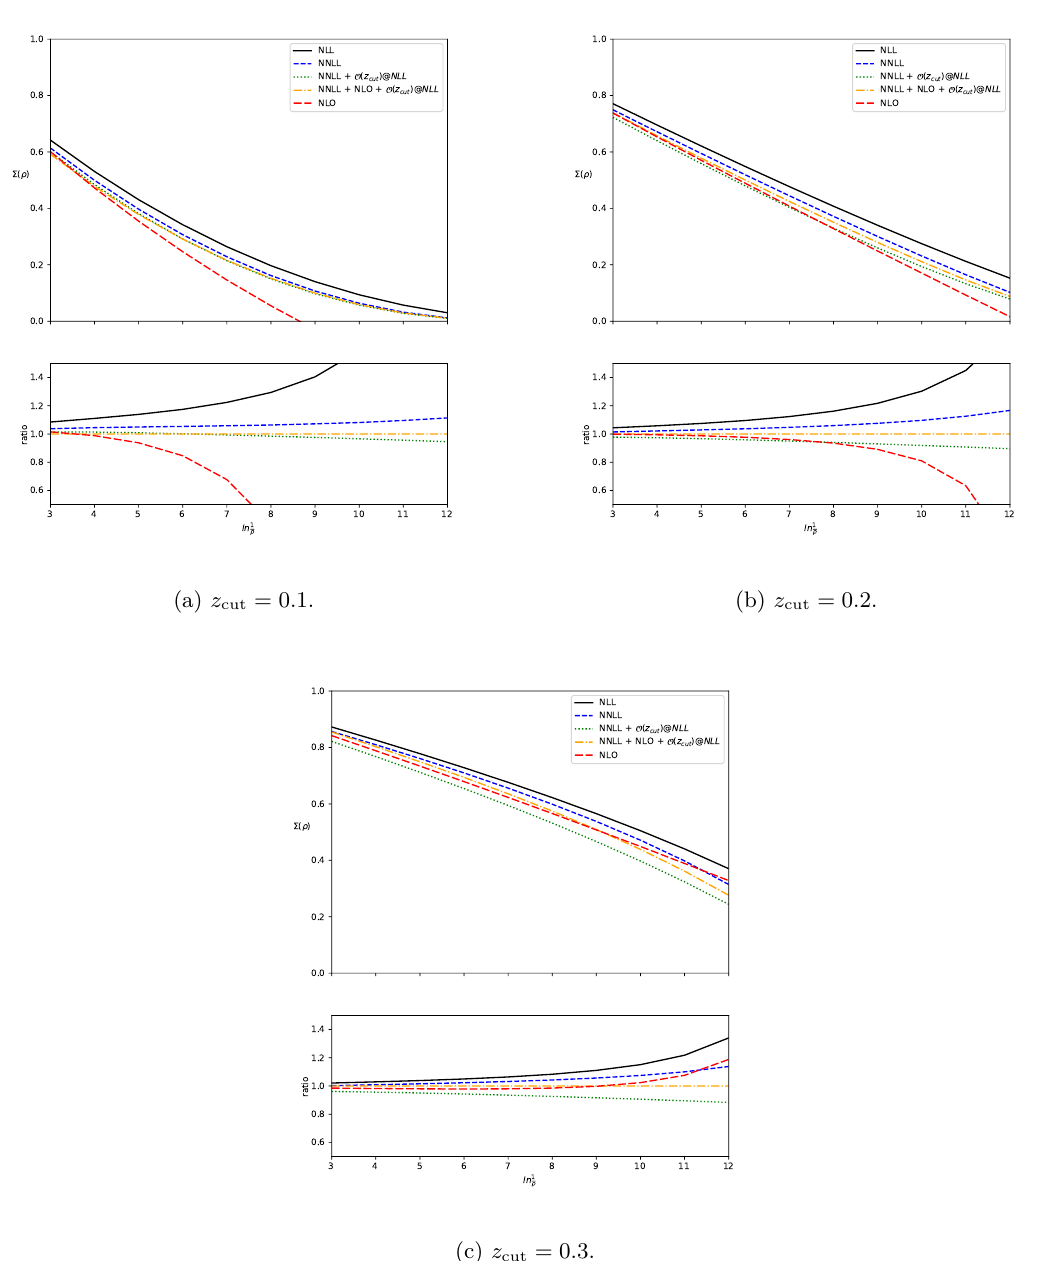
Figure 7. Predictions for the cumulative jet mass distribution at various levels of accuracy for three different values of z cut